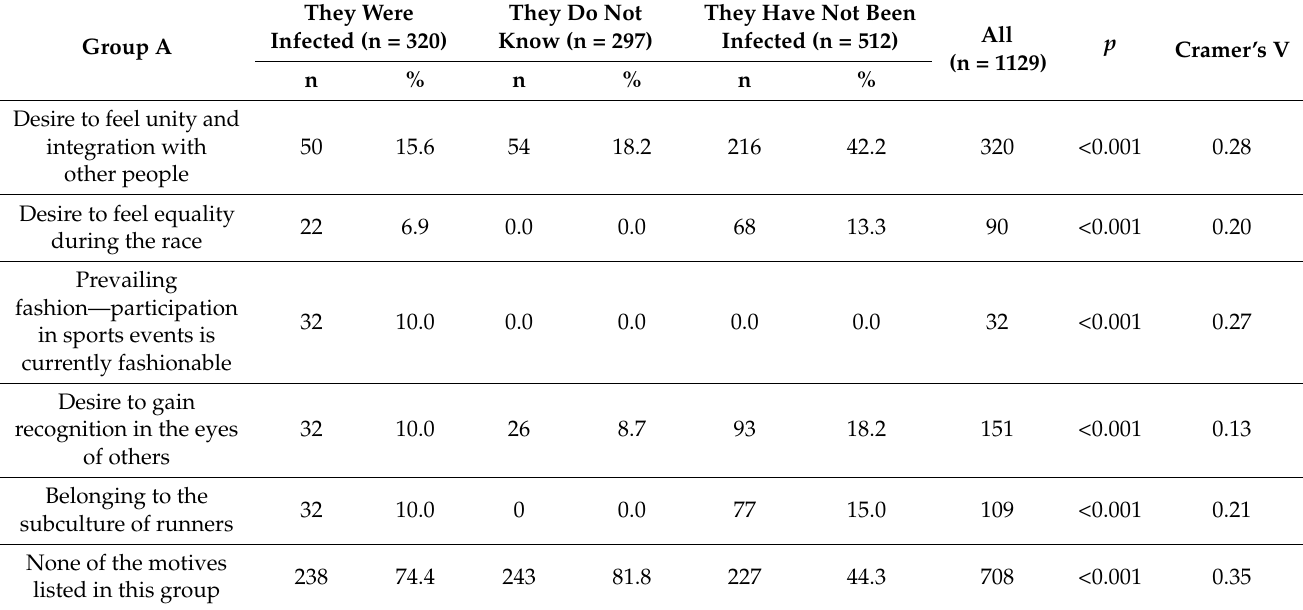
Table 2. Motives within the scope of social orientation versus COVID-19